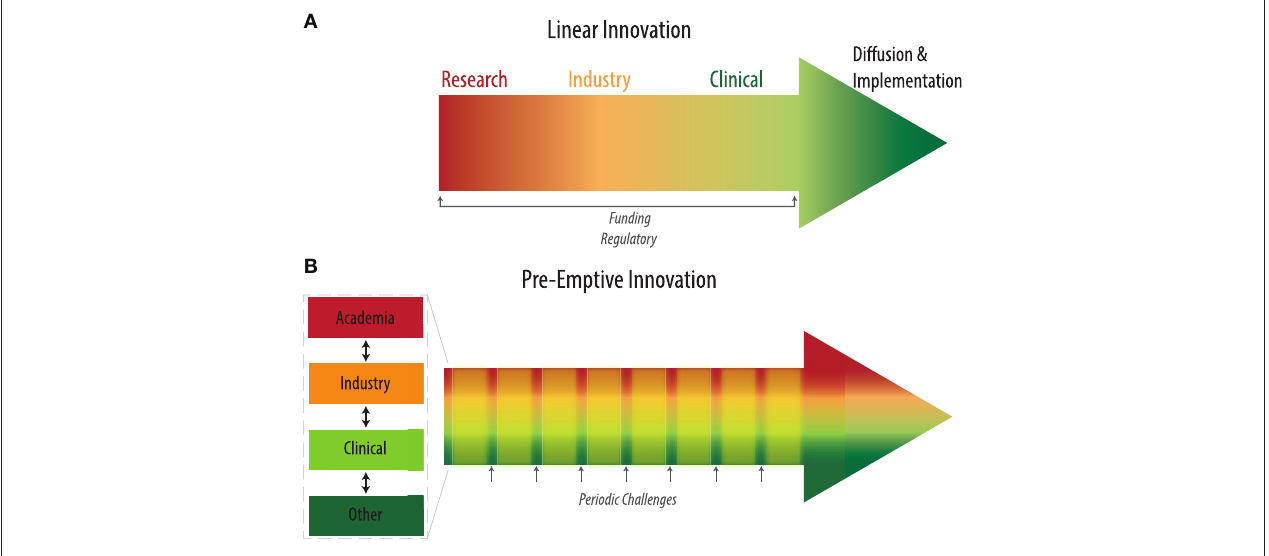
FIGURE 2 | (A) Existing linear pipeline for health innovation. (B) Pre-emptive innovation pathway incorporating regular periodic challenges that engage all stakeholders